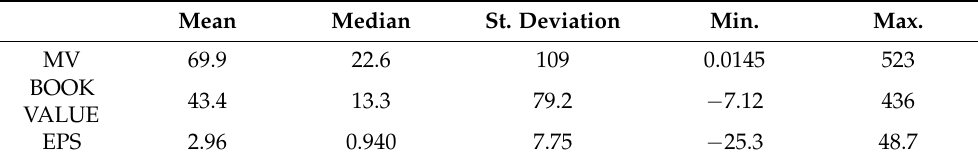
Table 2. Descriptive statistics. Source: built on the basis of the authors’ calculations.